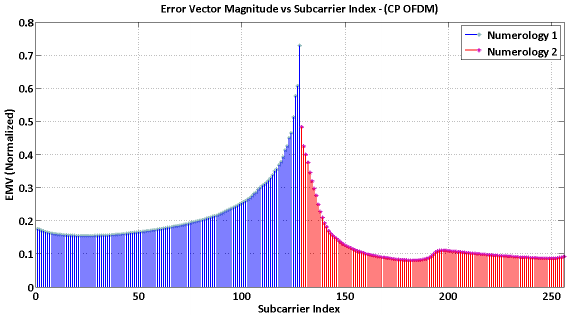
Fig. 4. CP OFDM: EVM versus the subcarrier index